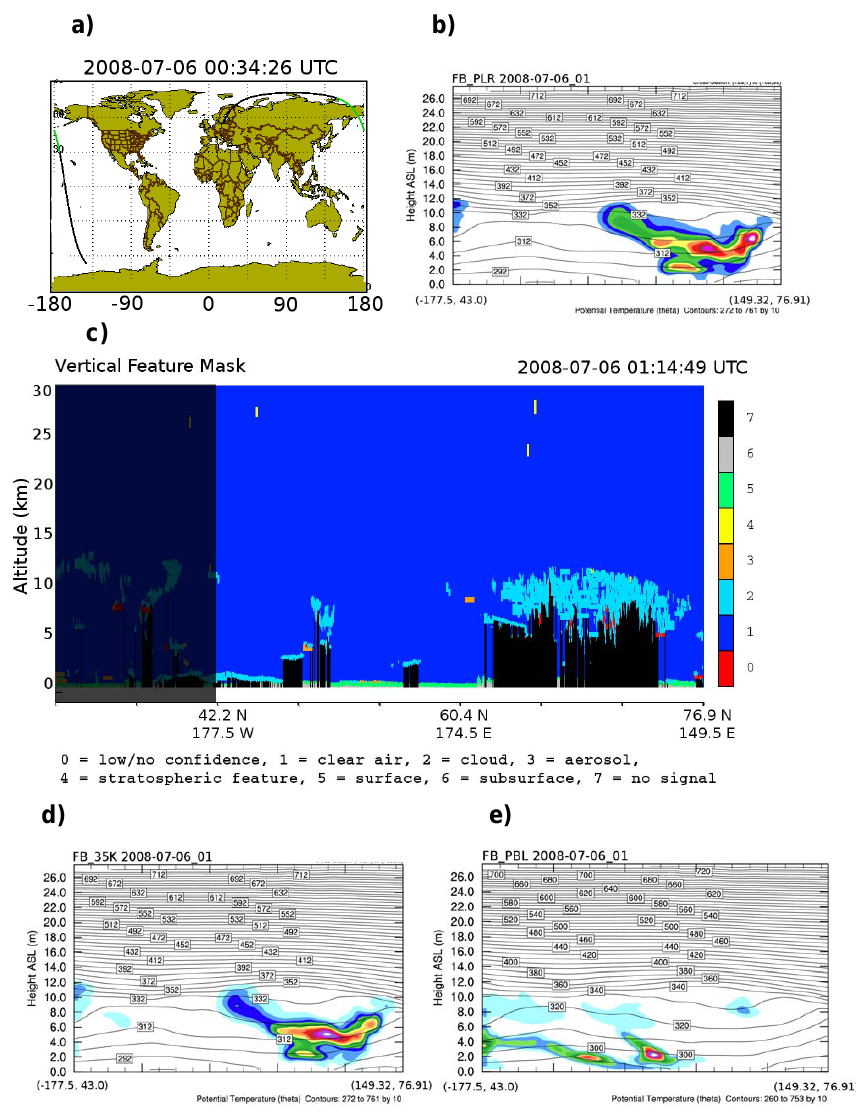
Fig. 11. a) Map of CALIPSO path at 0034 UTC 6 July 2008 with the analyzed segment over Russia in green and c) the CALIOP vertical feature mask (VFM). Normalized WRF aerosol plumes for b) Fig. 11. (a) Map of CALIPSO path at 00:34 UTC 6 July 2008 with the analyzed segment over Russia in green and (c) the CALIOP vertical feature mask (VFM). Normalized WRF aerosol plumes for (b) FB PLR, d) FB 35K, and (e) FB PBL along the CALIPSO track. The left side of each cross section is the south eastern starting point, while the right side is the north western ending